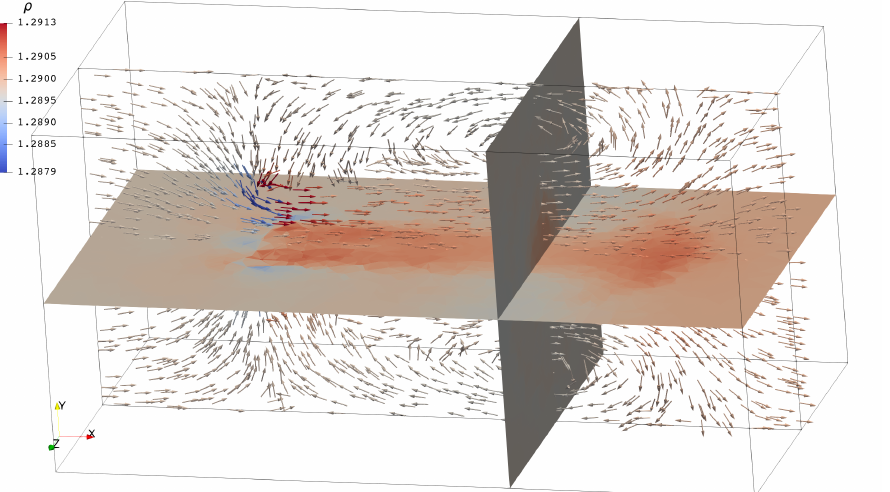
Figure 33. First-order solution of Problem 7 at t =